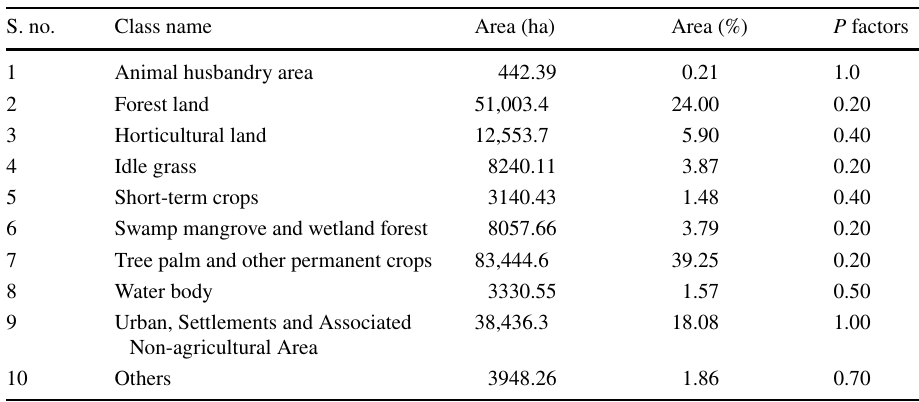
Table 5 Land cover classes and respective P factors. Source : Department of Irrigation and Drainage Malaysia (2008)